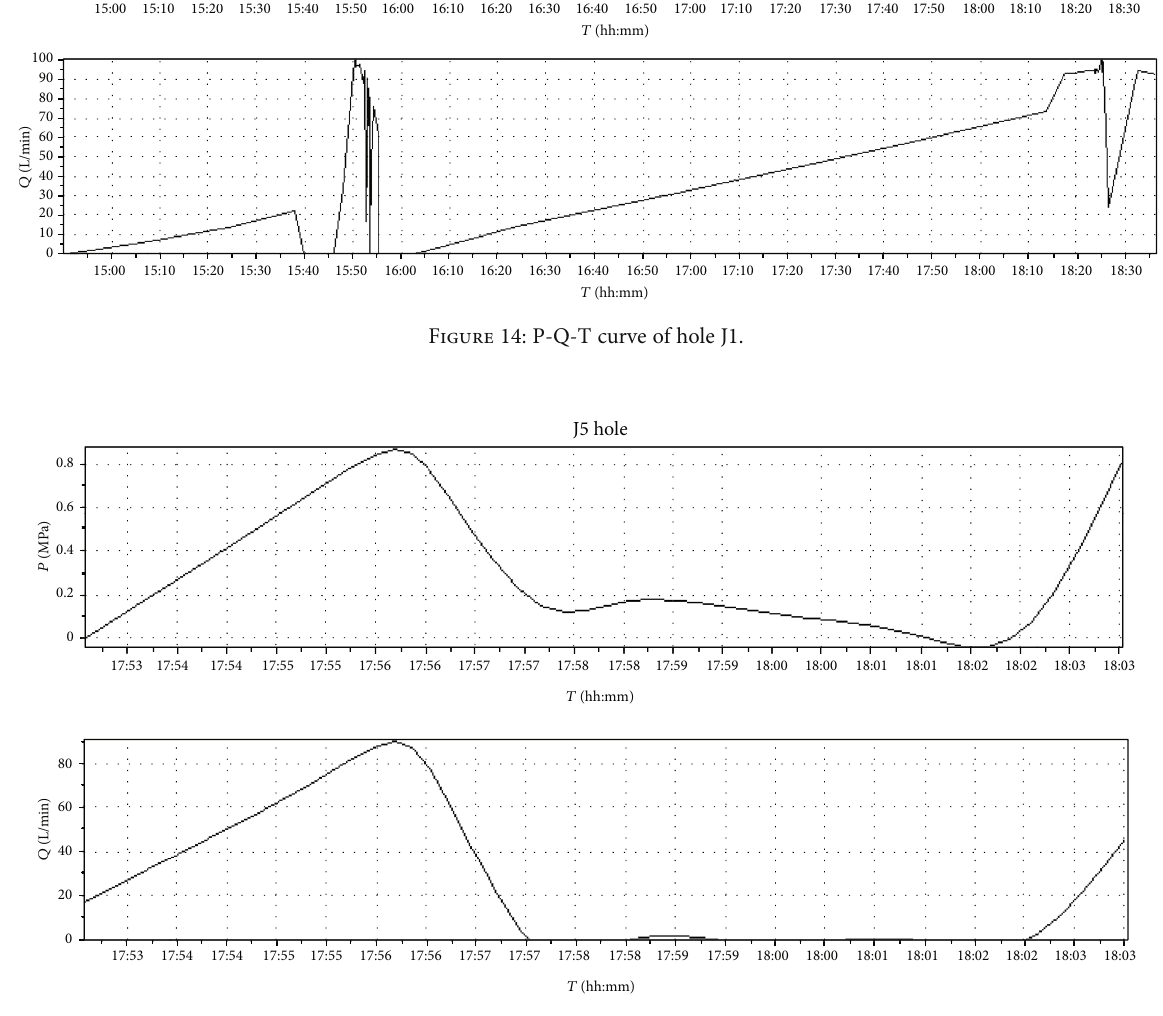
Figure 15: P-Q-T curve of hole